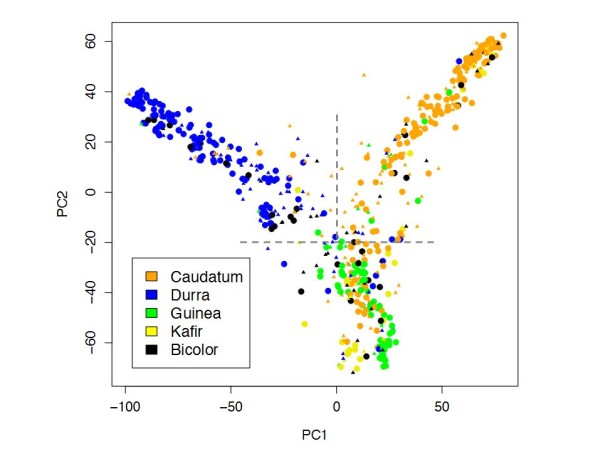
Sorghum racial identity and subpopulation structure. PCA plot of the 580 exotic progenitor (EP) lines genotyped in this study. Each dot represents an EP line, colored according to its morphologically-defined race. Larger circles and smaller triangles represent EP lines with more and fewer than 10% unexpected genotypes, respectively. The grey dashed lines indicate the criteria used to assign EP lines to genetic groups for subpopulation-specific introgression mapping.